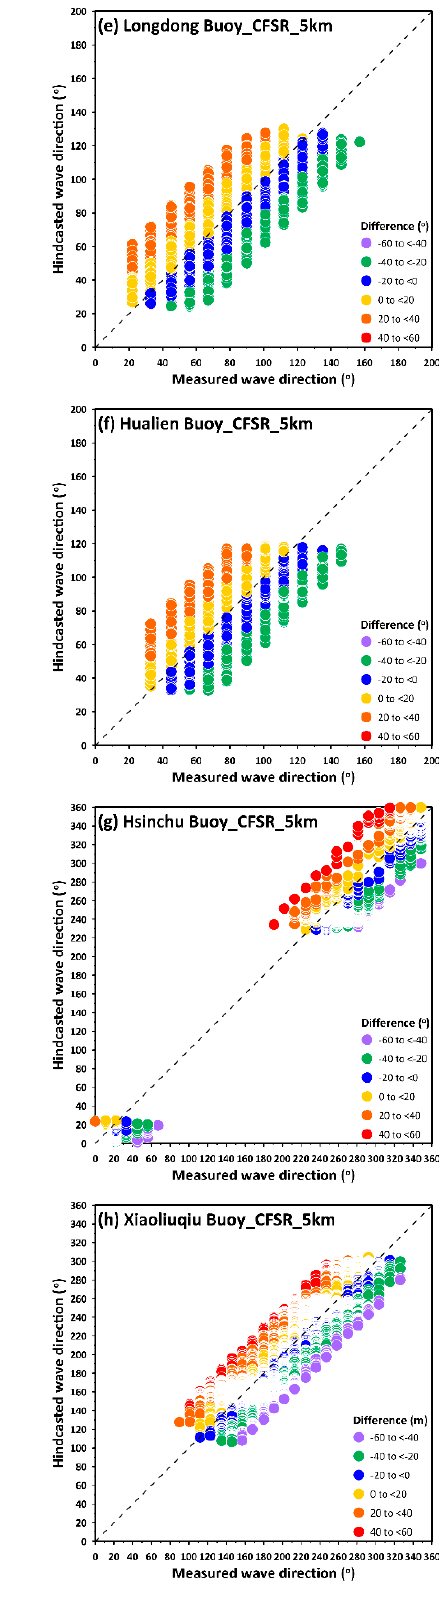
Figure 6. Scatter plots of the hindcasted versus measured wave directions for the ( a , e ) Longdong, ( b , f ) Hualien, ( c , g ) Hsinchu and ( d , h ) Xiaoliuqiu buoys using the ( a – d ) CFSR and ( e – h ) CFSR_5km winds.